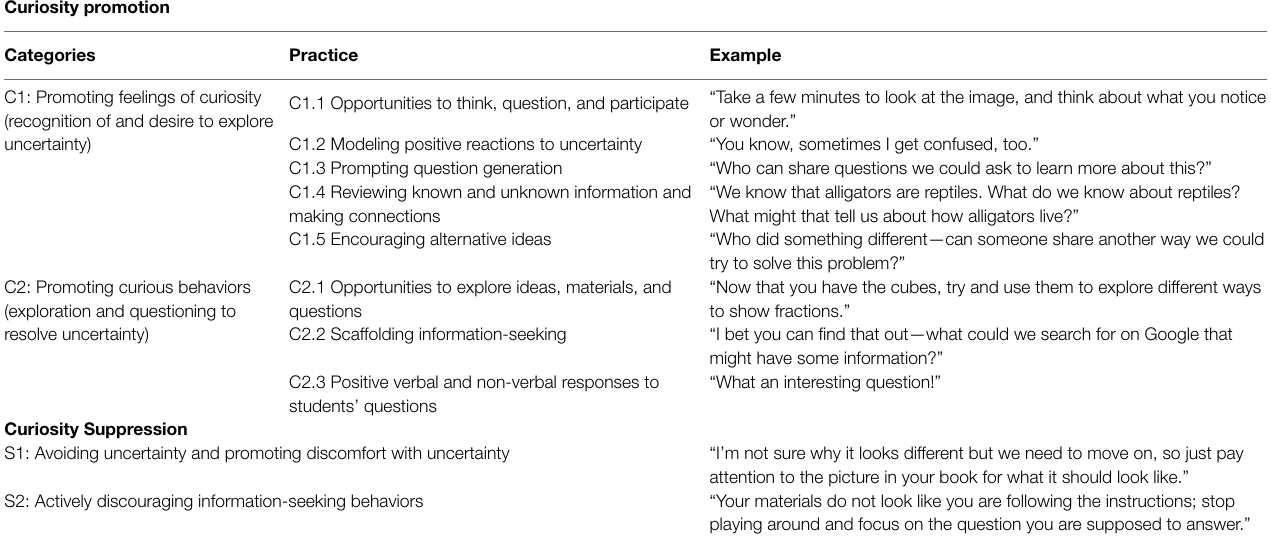
TABLE 1 | Curiosity in classrooms framework: types and examples of curiosity-promoting